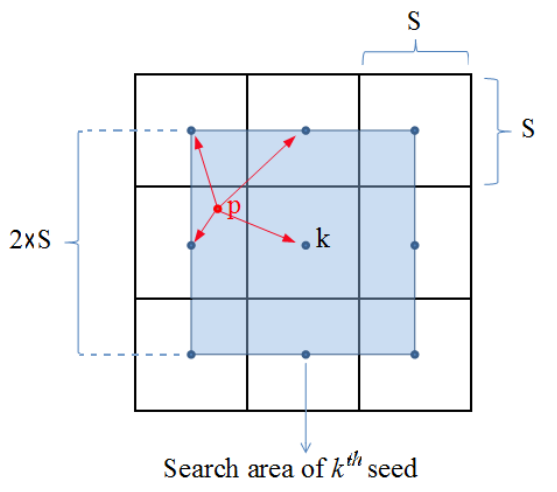
Figure 1. Each seed k has a search area of 2 S × 2 S to generate superpixels with size S × S , and each pixel p is likely to belong to 4